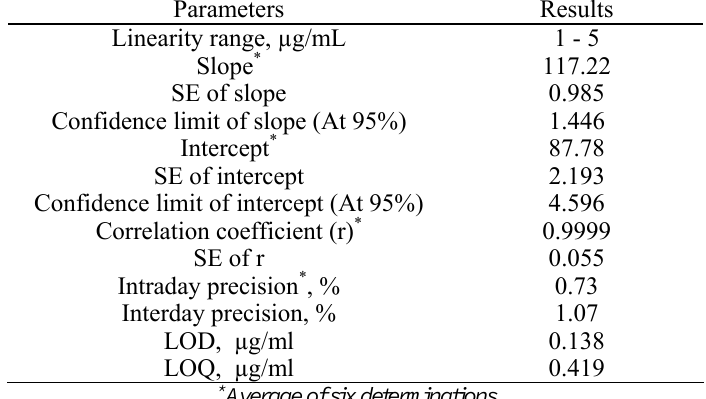
Table 1. Validation report for estimation of erlotinib hydrochloride